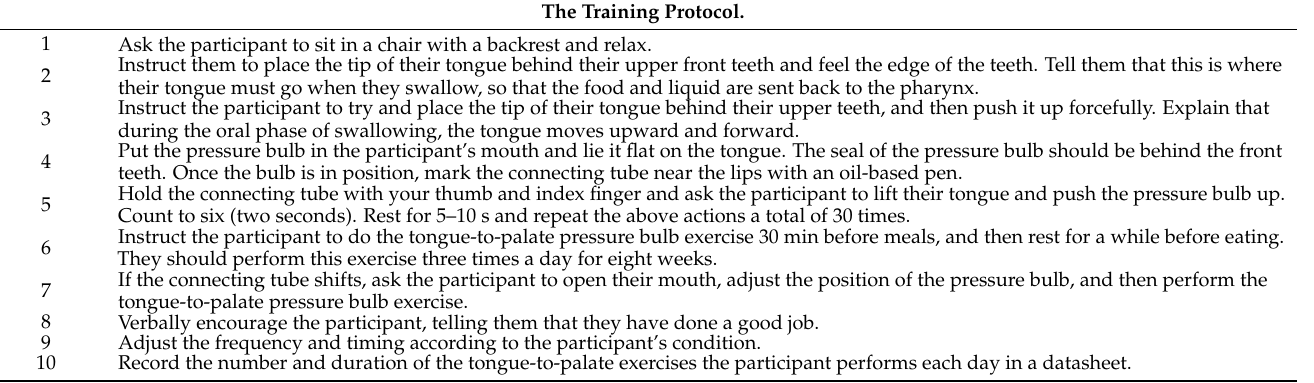
Figure 1. The placement of tongue bulb on tongue. Table 1. Training protocol step table. The Training